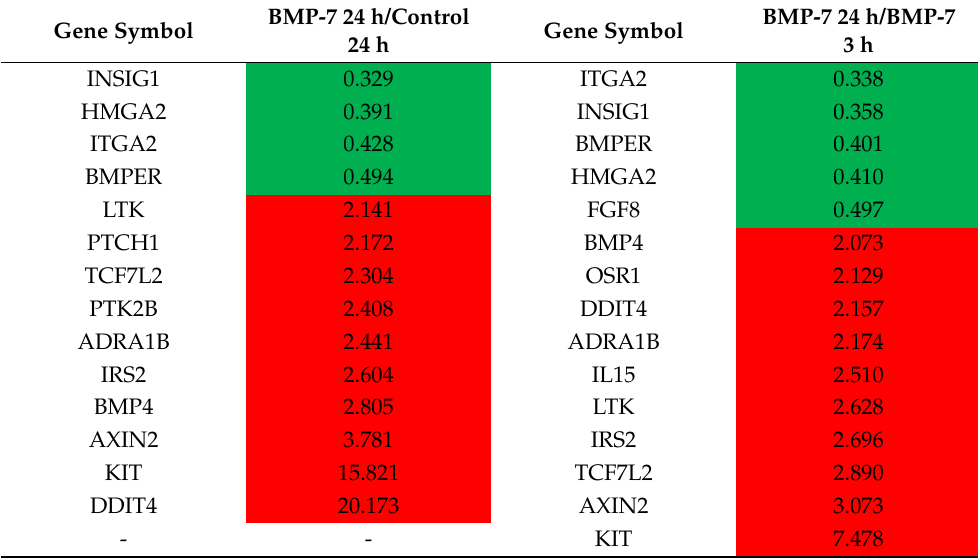
log2 normalized data >5 were selected). When comparing gene expression value between samples, the down-regulated gene was shown in green and up-regulated is in red.